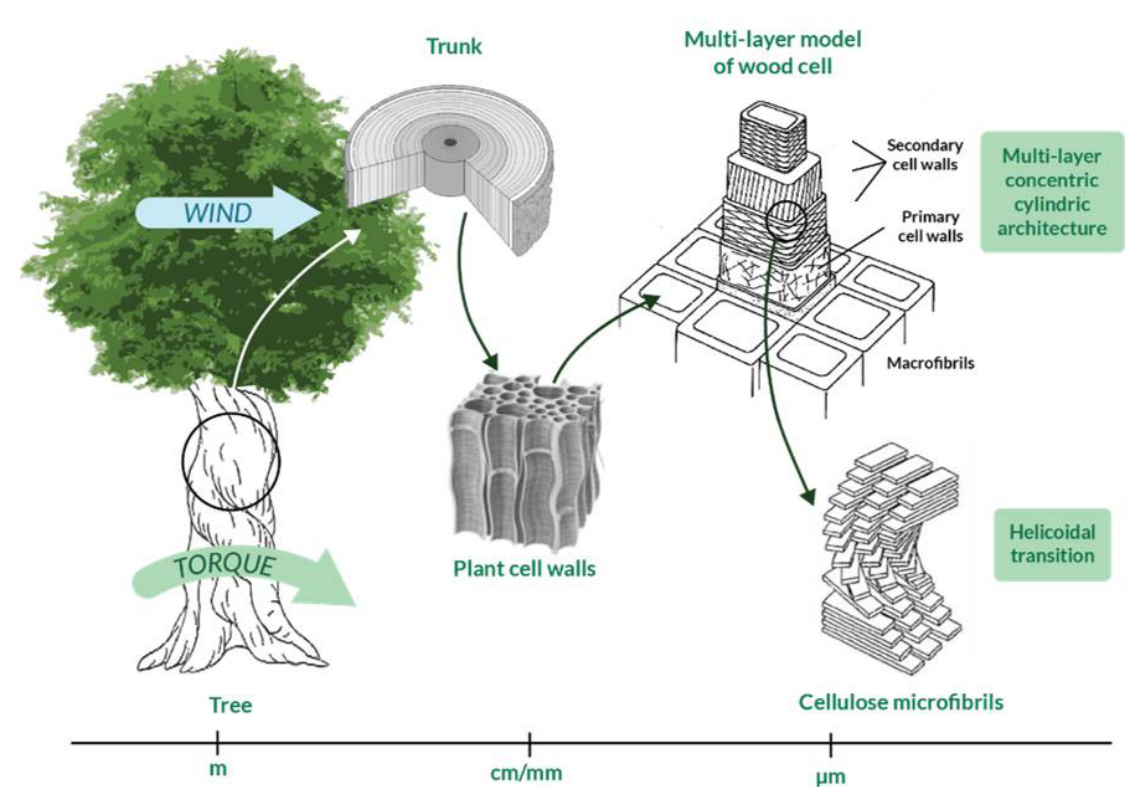
Figure 3. Hierarchical structure of wood from macroscale to microscale. Multi-layer concentric cylindric architecture and helicoidal transition are peculiarities that allow for torsion resistance and a progressive transition of properties, respectively.